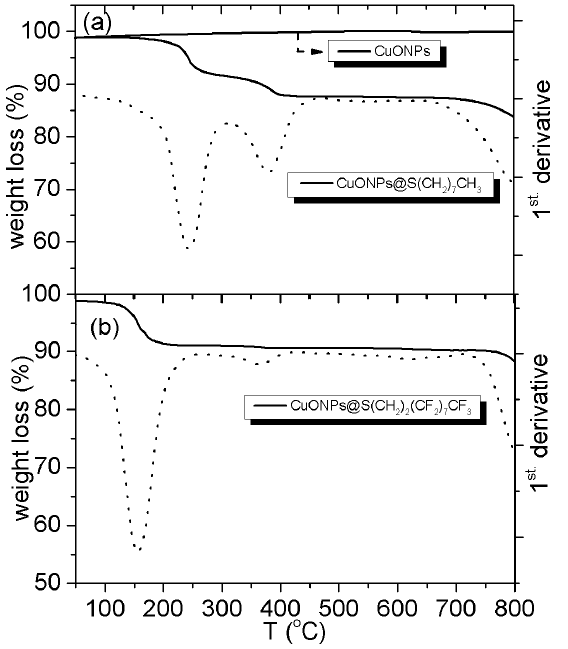
Figure 3. Thermograms and the corresponding differential curves for ( a ) naked CuONPs and CuONPs@CH and ( b ) CuONPs@CF.